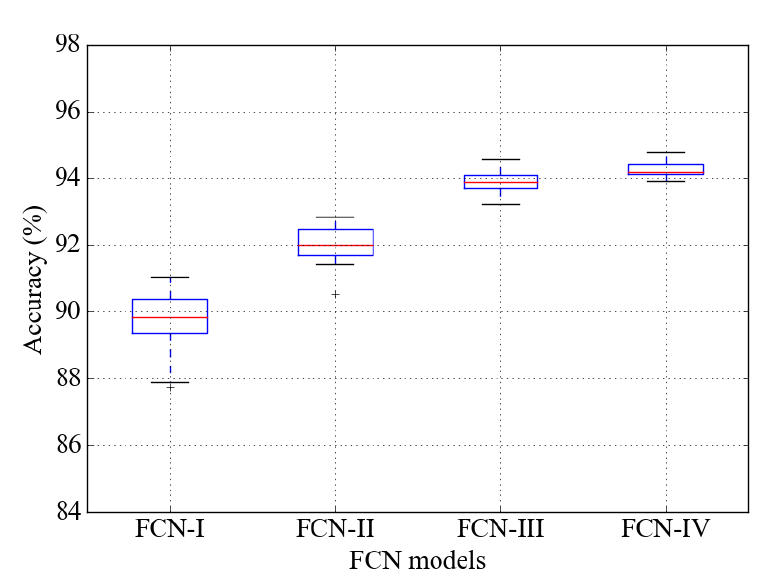
Figure 5. Performance comparison of the FCN models.